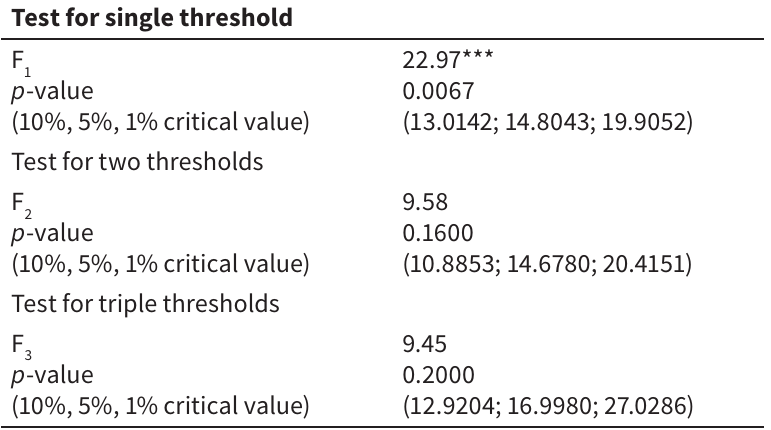
Tests for threshold